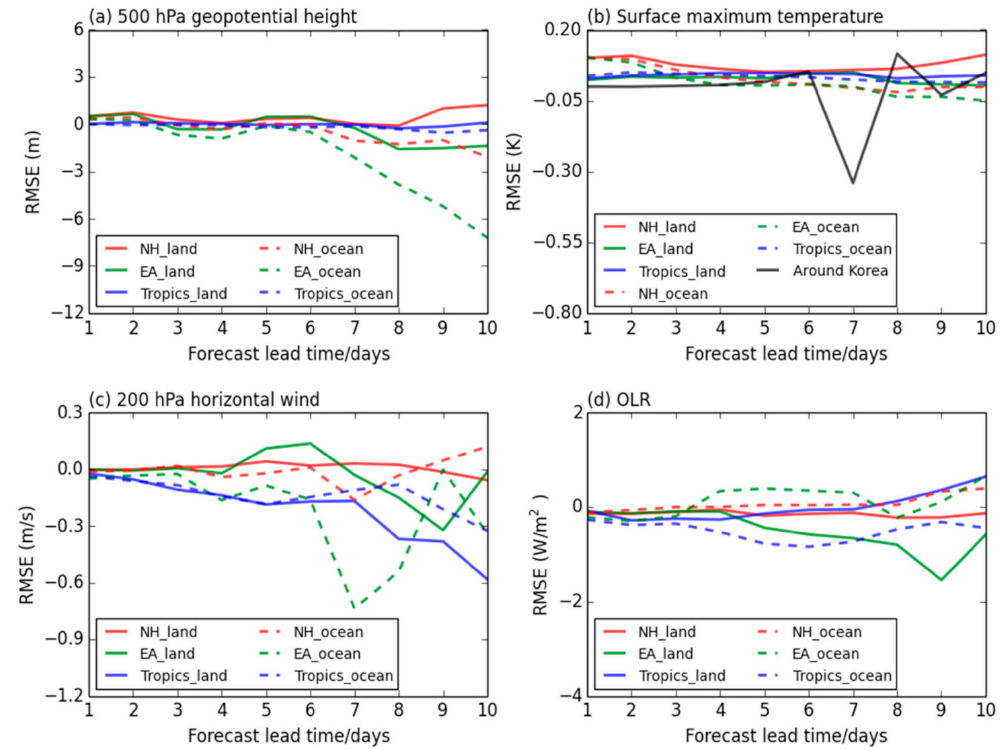
Figure 10. Di ff erences of RMSE between the CP and the CTL experiments (CP-CTL) in ( a ) 500 hPa geopotential height (m), ( b ) daily maximum temperature at 1.5 m (K), ( c ) 200 hPa horizontal wind (m / s) and ( d ) OLR (W / m 2 ) at each forecast lead time averaged over each area (northern hemisphere: 20 ◦ N–90 ◦ N, tropic: 20 ◦ S–20 ◦ N and East Asia: 25 ◦ N–70 ◦ N, 90 ◦ E–180 ◦ E, around Korea: 25 ◦ N–50 ◦ N, 115 ◦ E–140 ◦ E) during the targeted case period (11–25 August 2016). Contour (dashed) line means averaged value over ocean (land) area of each region. Negative values mean that the CP experiment reduces RMSE compared to the CTL